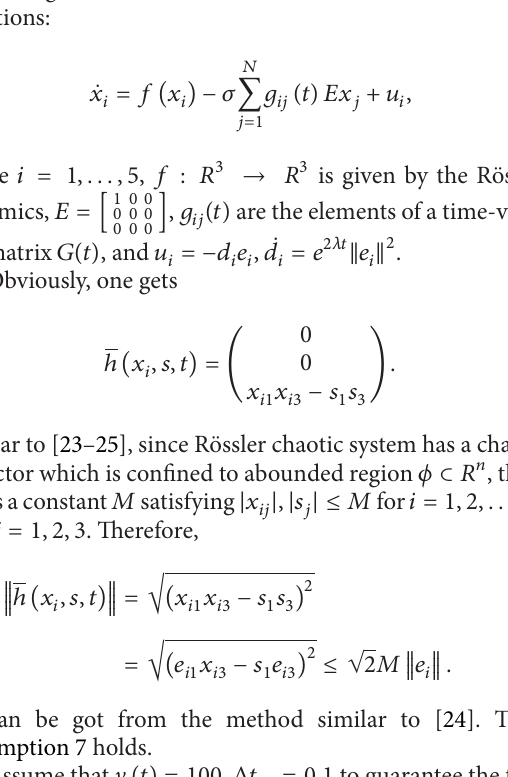
Figure 3: Synchronization errors of 𝑒 𝑖2 for the network.